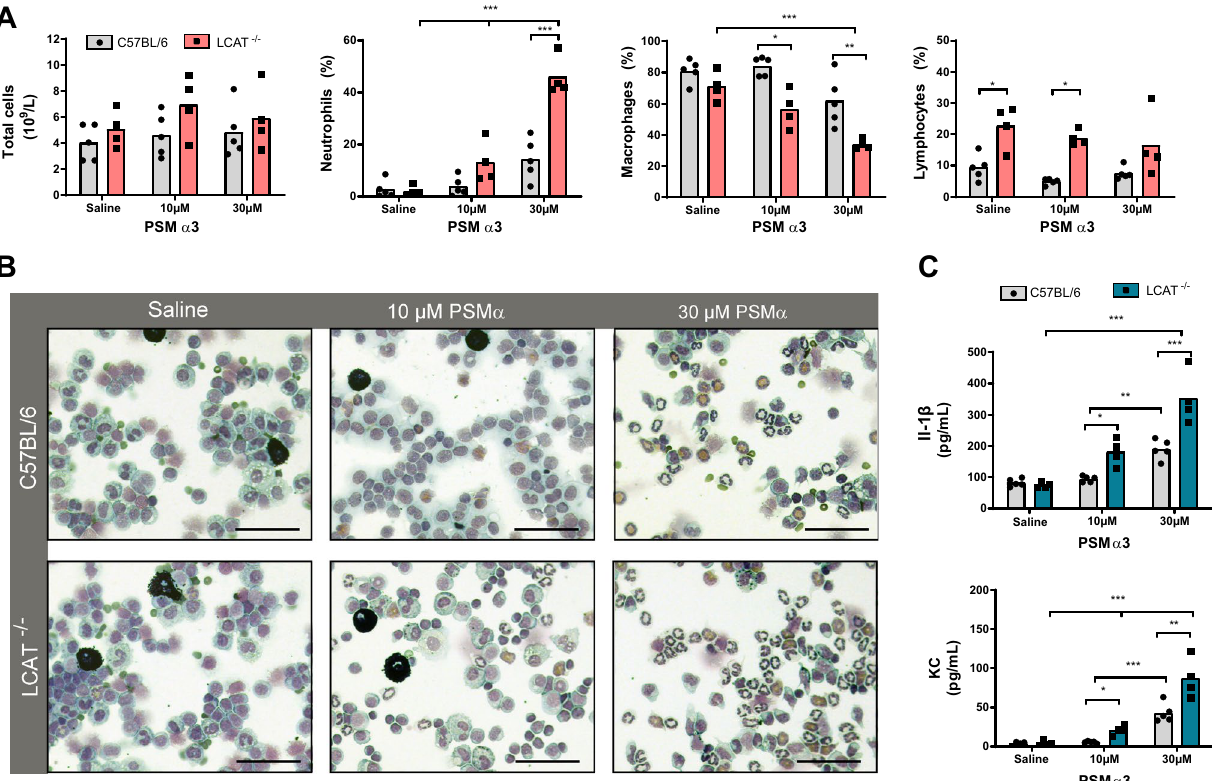
Figure 3. LCAT deficiency enhances neutrophil influx in murine PSM-induced peritonitis model. Peritonitis was induced by injecting 1 mL of saline or 10 µM or 30 µM filter-sterilized PSMα3. Peritoneal leukocytes were harvested and analyzed 6 h after PSM injection, using a hematology Sysmex XT-2000iV analyzer and the total number of cells was quantified ( A ) and the percentage neutrophils, macrophages and lymphocytes was determined. ( B ) Photomicrographs of representative diff-quick stained cytospins of peritoneal cells. Original magnification × 200, bars indicate 50 µm. ( C ) Plasma cytokine levels of IL-1β and KC. Each dot represents